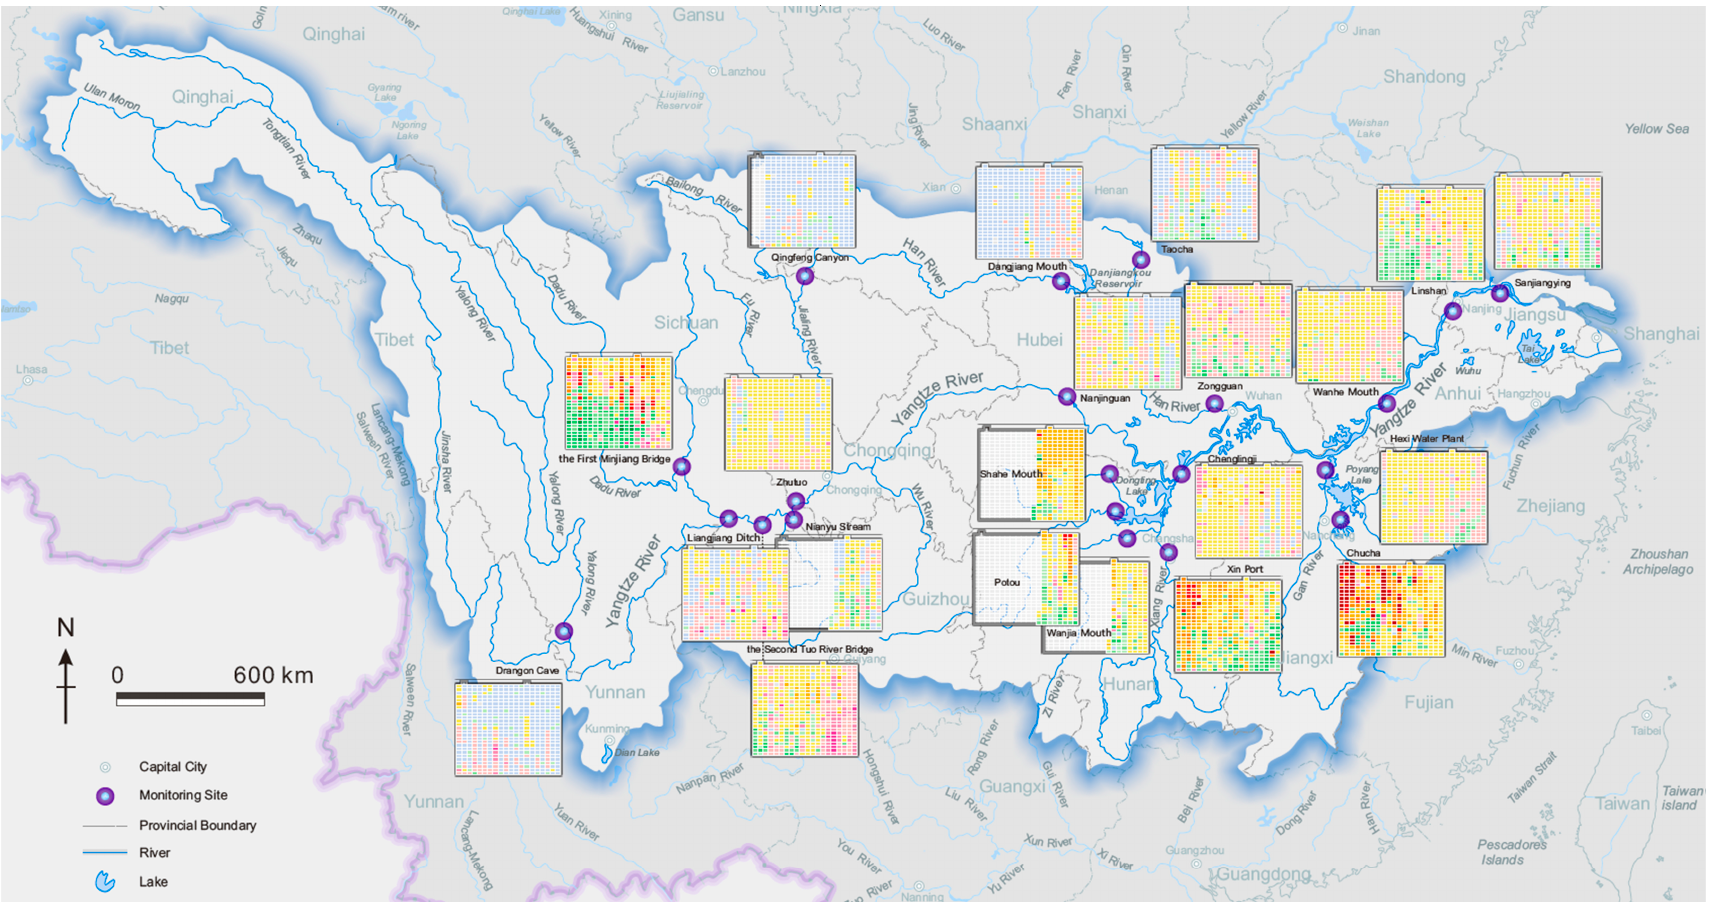
Figure 3. The spatial change of water quality in the Yangtze River basin. (The water quality data of the Yangtze River during 2006–2015 are represented using the proposed calendar method. According to the rendering rule defined in Table 2, the colors in calendar view indicate the major water pollutants and the corresponding water quality levels qualitatively.